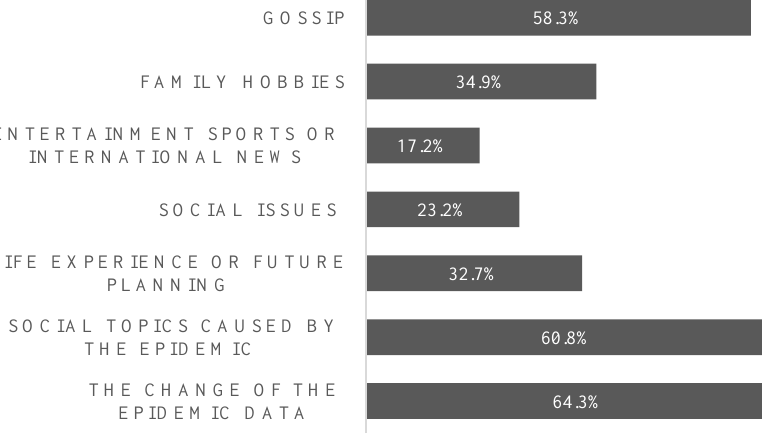
Figure 2. Key elements of communication between the interviewees and their family member.